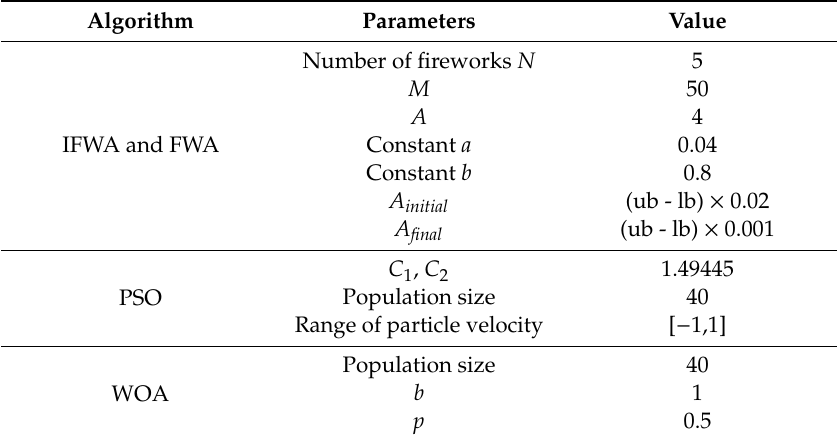
Table 5. Parameter settings in the HFSP.